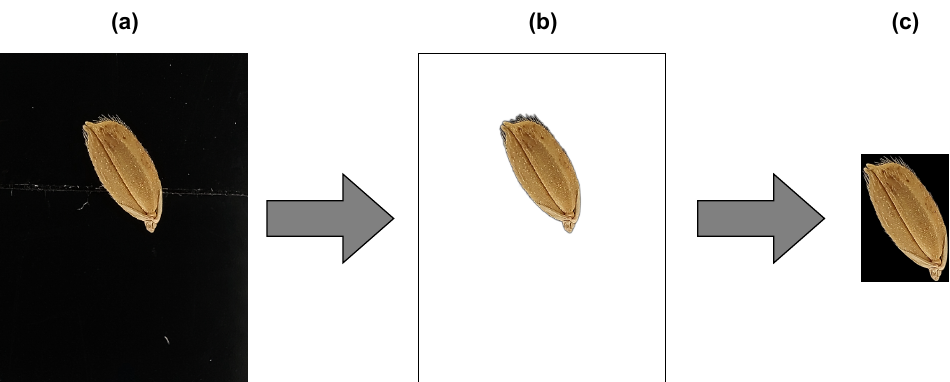
Figure 2. Image preprocessing steps. ( a ) The images were captured using a smartphone camera. ( b ) The backgrounds were removed from the raw dataset. ( c ) Seeds were cropped and